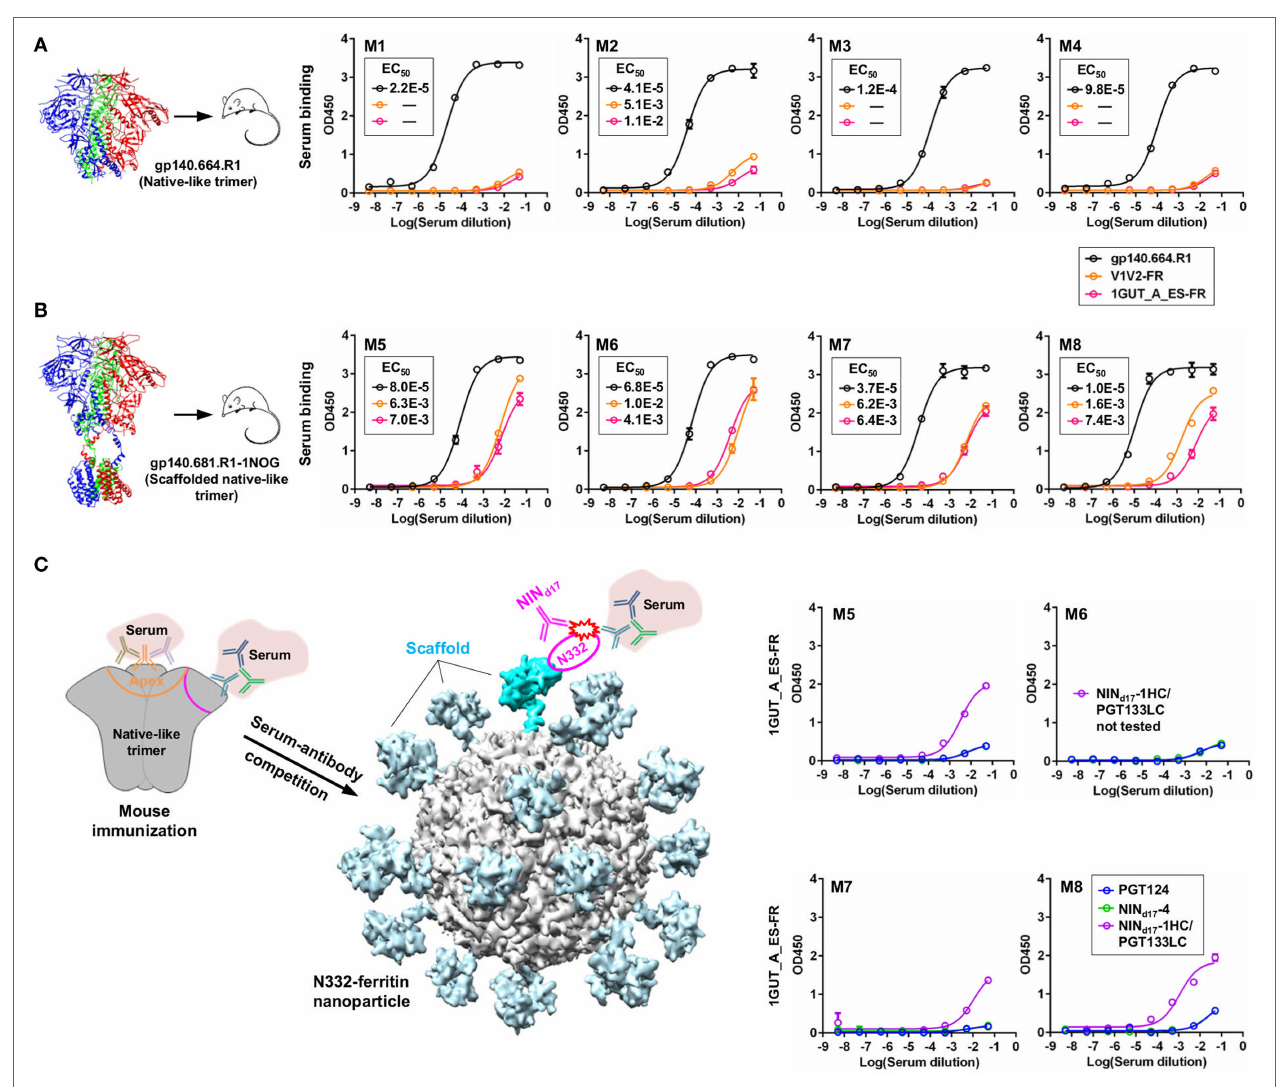
FigUre 9 | Detection of N332-specific antibody responses in trimer immunization by library-derived PGT124 lineage intermediates. (a) Enzyme-linked immunosorbent assay (ELISA) binding of mouse sera elicited by a native-like gp140 trimer (gp140.664.R1) to the trimer immunogen and two nanoparticles (V1V2-FR and 1GUT_A_ES-FR). The structure of this trimer (PDB ID: 5JS9) is shown on the left, with ELISA plots for four subjects in this group (M1–M4) shown on the right. (B) ELISA binding of mouse sera elicited by a scaffolded full-length gp140 trimer (gp140.681.R1-1NOG) (39) to the parent trimer (gp140.664.R1) and two nanoparticles (V1V2-FR and 1GUT_A_ES-FR). The structural model of this scaffolded trimer is shown on the left, with ELISA plots for four subjects in this group (M5–M8) shown on the right. (c) ELISA binding of mouse sera elicited by the gp140.681.R1-1NOG trimer to an N332 nanoparticle (1GUT_A_ES-FR), in which PGT124 and two intermediate variants (NIN d17 -4 and NINd17-1HC/PGT133LC) were added to compete for the N332 supersite. A diagram of the competition ELISA is shown on the left, with ELISA plots for four subjects in this group (M5–M8) shown on the right. EC 50 values are labeled for all ELISA plots except for instances in which the highest OD 450 value is below 0.1 or in the cases of ambiguous data